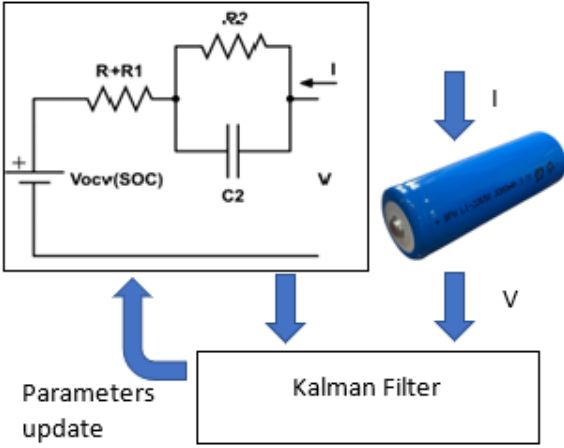
Figure 9. General SOC estimation scheme using Kalman filter.